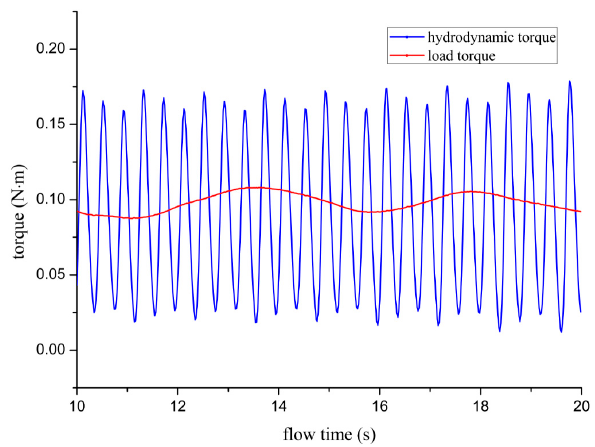
Figure 10. Time history curve of the hydrodynamic moment and the load moment.